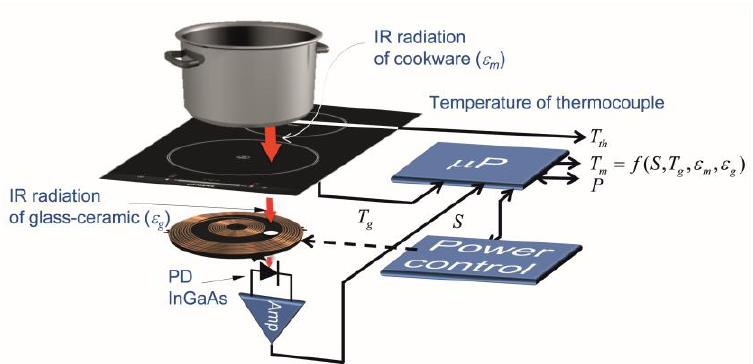
Figure 7. Diagram of the temperature control system.